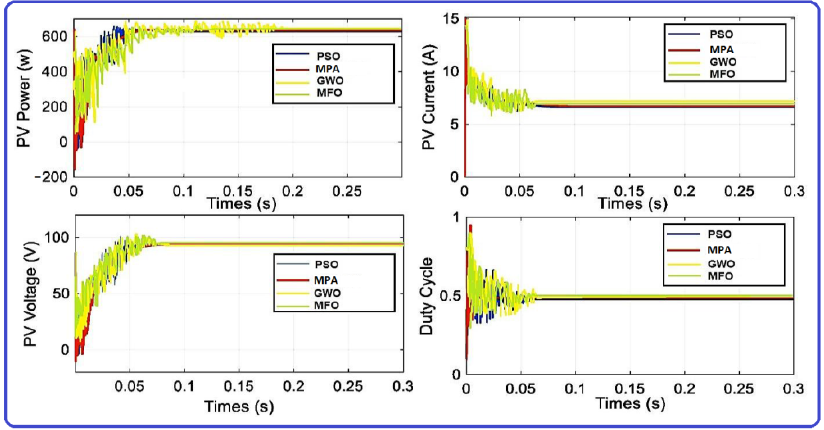
Figure 9. PV power, voltage, current and duty for MPA, PSO, GWO, and MFO during case 3.